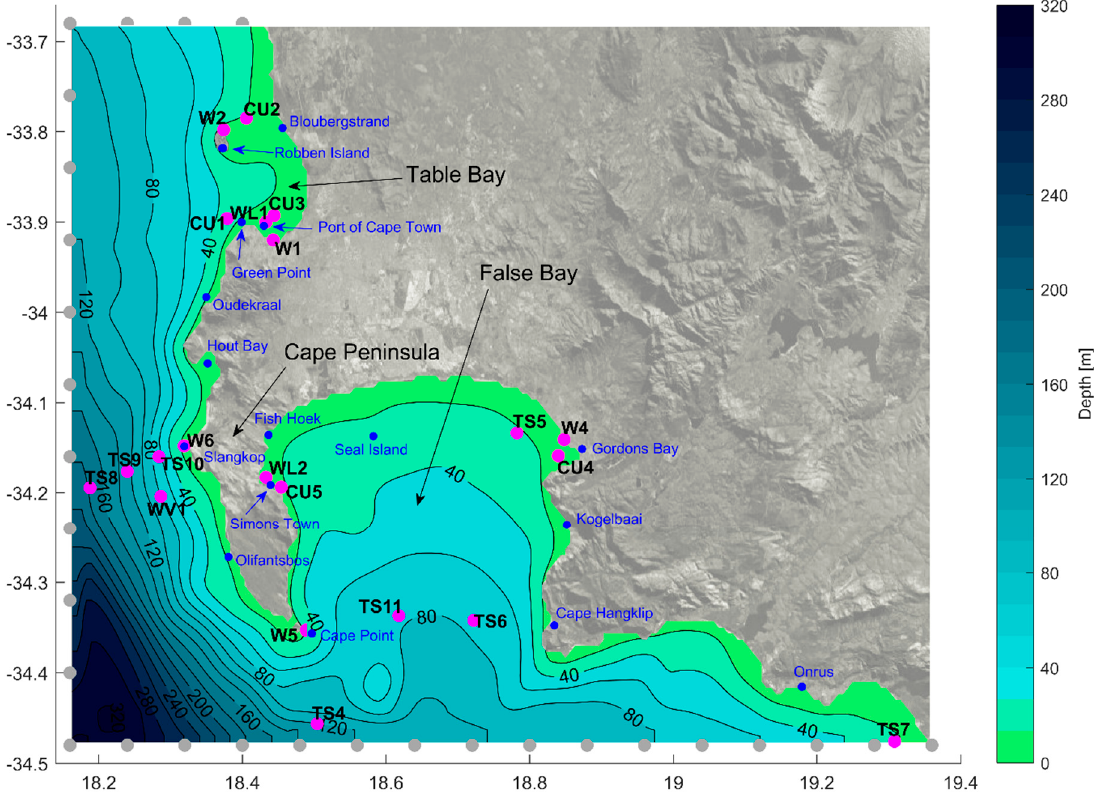
Figure 1. A map providing general geographical context for the study. The HRM model bathymetry is shown. Grey dots along the model boundaries indicate alignment with the global HYCOM grid and are the nodes at which temperature and salinity boundary conditions are prescribed. All measurement sites relevant to the calibration and validation are shown by magenta markers. Name codes correspond to those in Table 1 and Tables A1–A4. Points of interest are indicated in